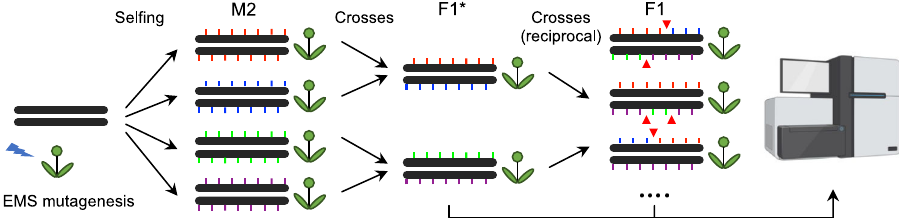
Fig. 1 Experimental design for CO identi fi cation in Arabidopsis inbred lines. M2 plants were derived from the sel fi ng of independent EMS-treated seeds. Pairs of M2s were crossed to produce F1*s, which are then heterozygous for a set of unique mutations de fi ning two phases, indicated by coloured ticks. Two F1*s were then reciprocally crossed to generate F1 populations. The DNA of leaves of F1* and F1 plants were sequenced using Illumina. The colour- coded ticks indicate EMS-induced mutation markers. The red triangles represent COs, detected by phase switching. This design allows the detection of COs that occurred in the female and male meiocytes of the F1* plants. The sequencer fi gure was created with